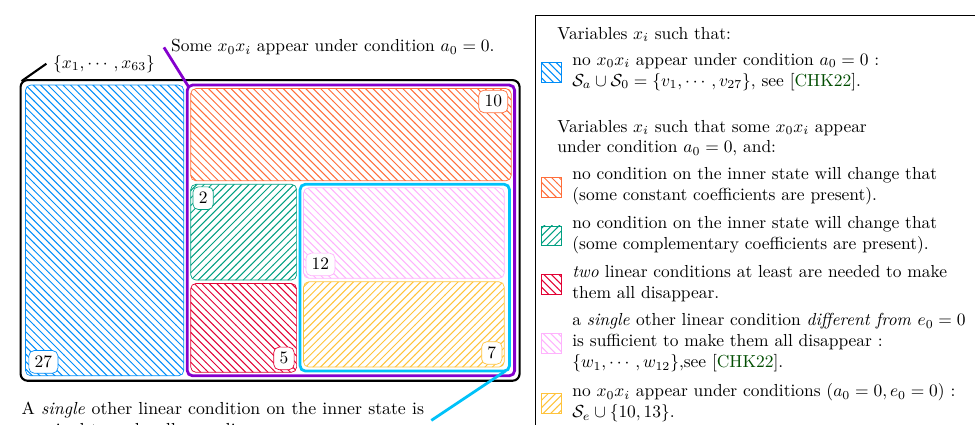
Figure 8: Overview of the quadratic monomials x 0 x i , i ∈ { 1 , . . . , 63 } after the second